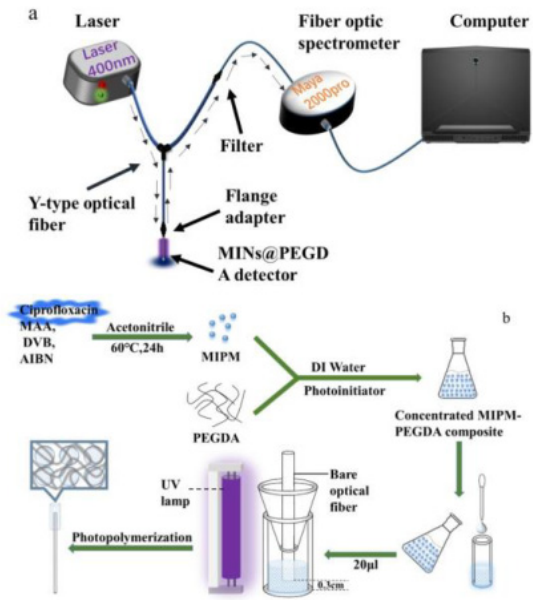
Figure 6. Scheme of MIFOFS and MINs@PEGDA detector (( a ) Diagram of MIFOFS system; ( b ) outline draft for modification of the MINs@PEGDA detector) [110].